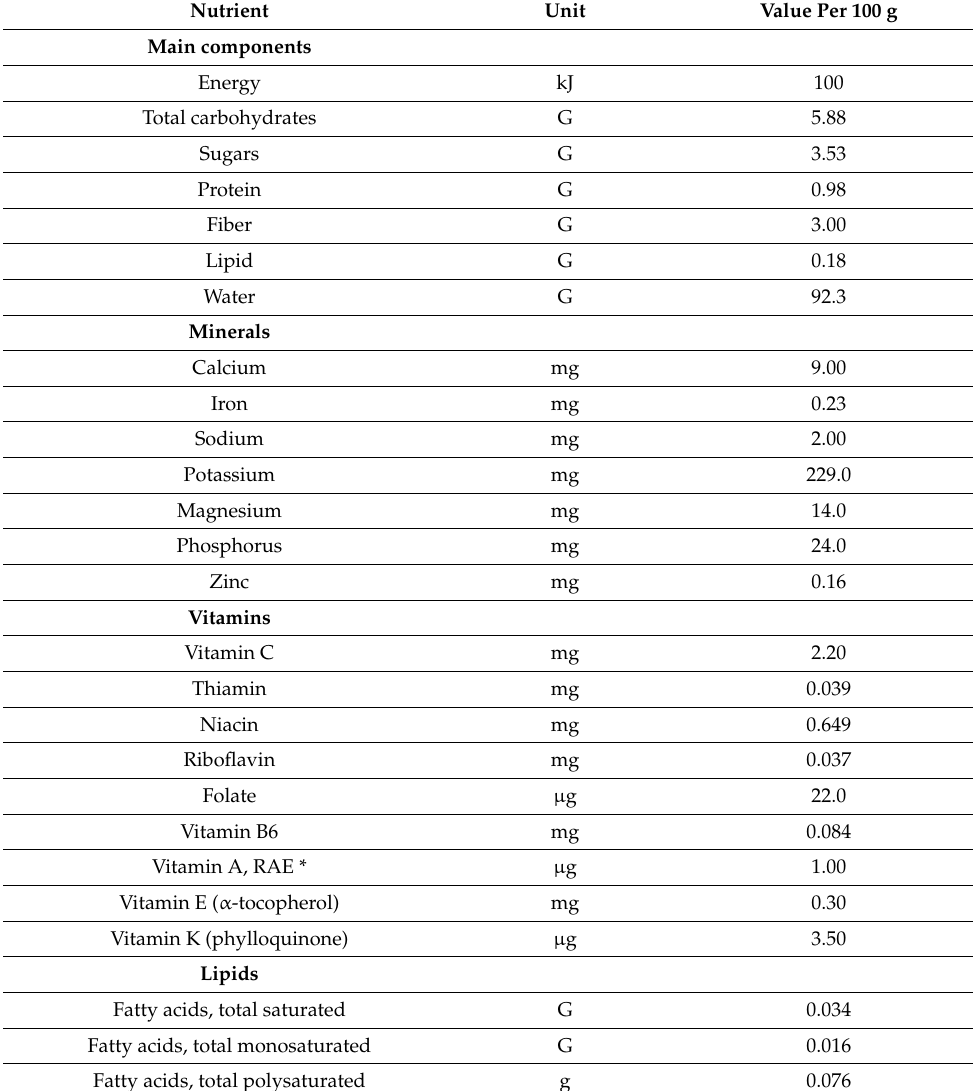
Table 1. Nutritional components of eggplant